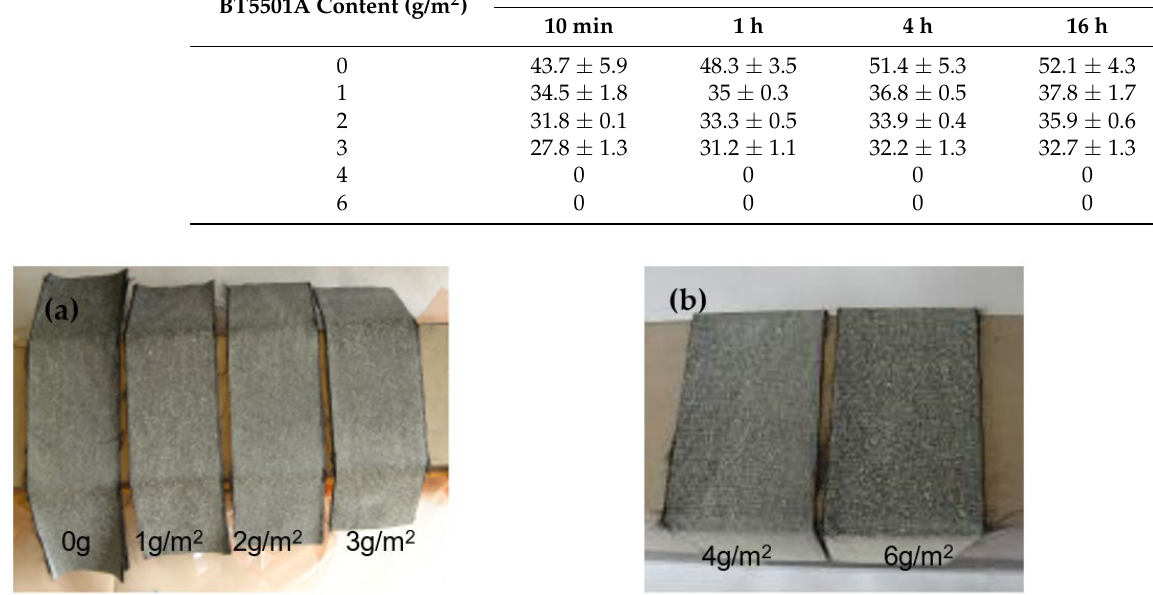
Figure 7. Images of ( a , b ) the bifunctional CF fabrics treated at 80 ℃ /45 min in vacuum for the preforming evaluation.